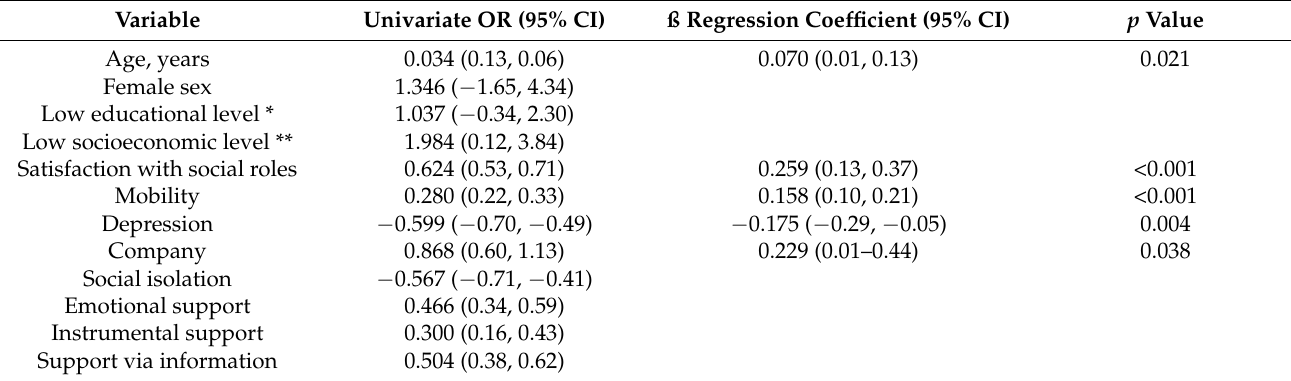
Table 3. Multivariable linear regression analysis of the characteristics associated with ability to participate in social activities in patients with rheumatic